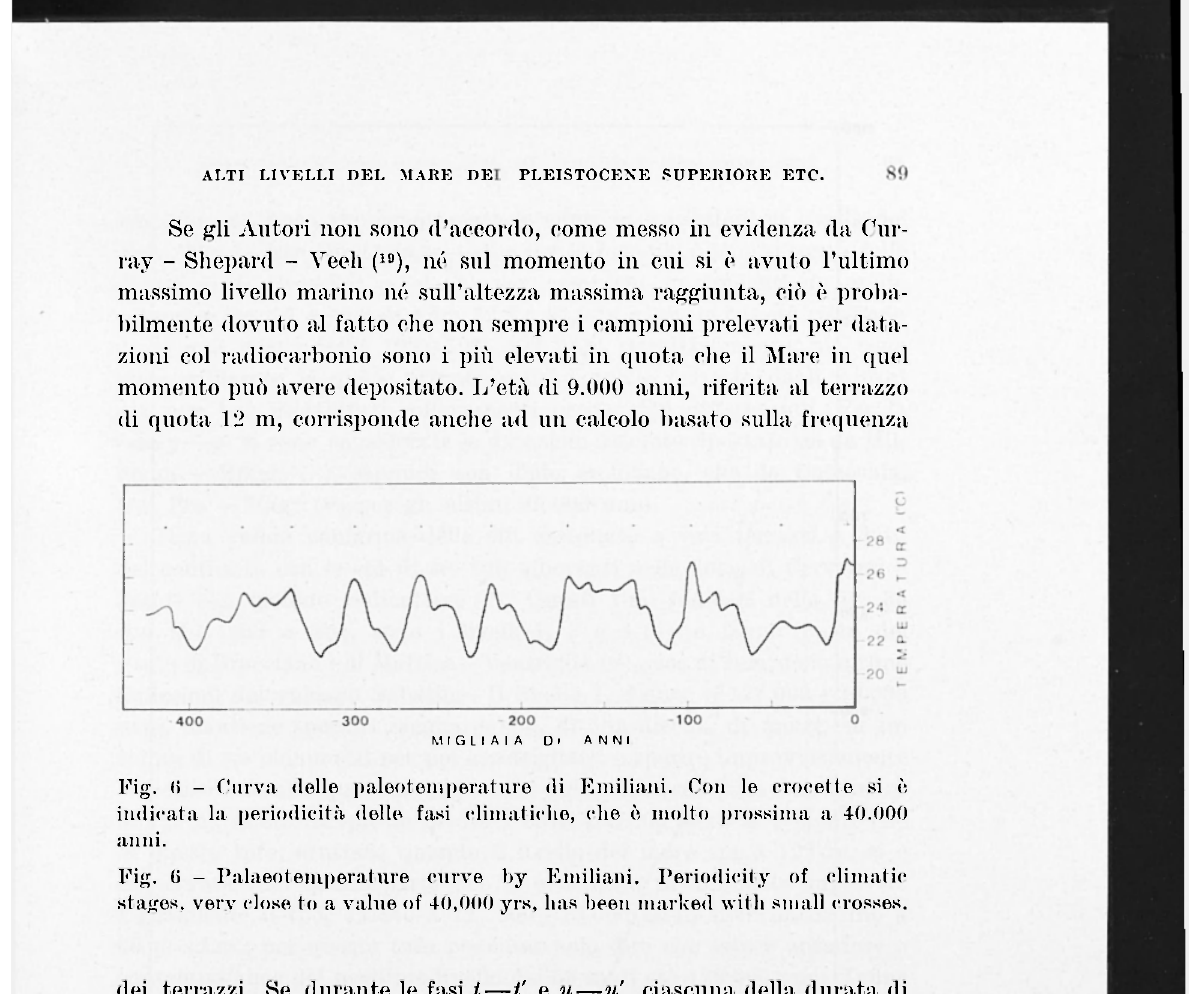
dei terrazzi. Se durante le fasi t—t' e u—«', ciascuna della durata di 40.000 anni, si sono formati 8 + 9 + 8 + 8 = 33 terrazzi, ogni terrazzo